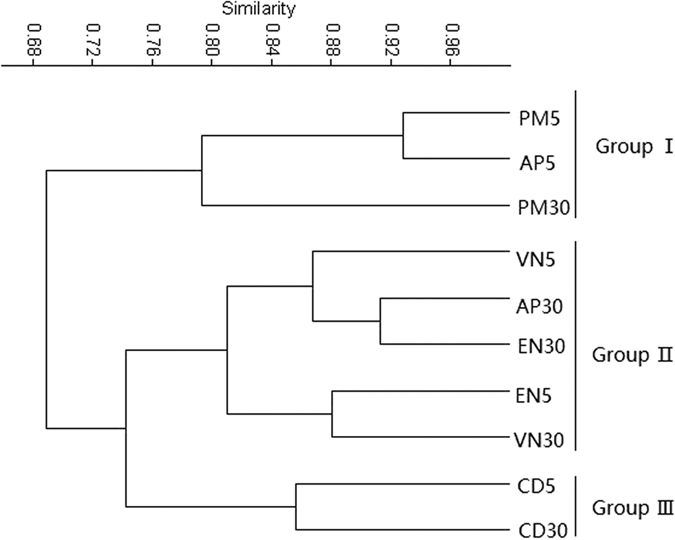
Cluster analyses of the bacterial community structure based on Bray-Curtis (5 and 30 indicate samples exposed to 5 and 30 mg L−1 NO3−-N, respectively).PM, P. malaianus; AP, artificial plants; VN, V. natans; EN, E. nuttallii; CD, C. demersum.